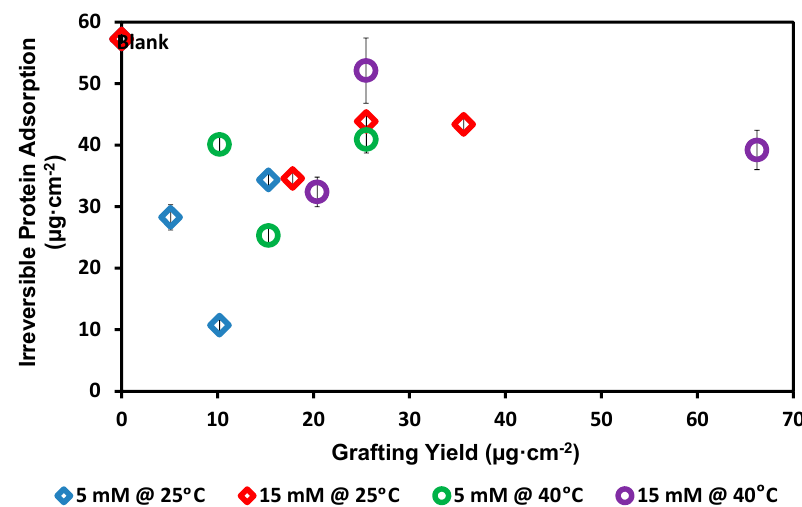
Figure 6. The effect of the grafting yield on the irreversible protein adsorption. Common reaction condition is pH 5.5 (0.1 M sodium acetate buffer), and 0.5 U·mL − 1 enzyme (laccase). Reaction at 25 °C using 5 mM 2-AP (blue diamond) and 15 mM 2-AP (red diamond), and reaction at 40 °C using 5 mM 2-AP (green circle) and 15 mM 2-AP (purple circle). Resection times 30, 60, and 120 min were tested and the grafting yield was increased with increasing the reaction time. Adsorption test was done